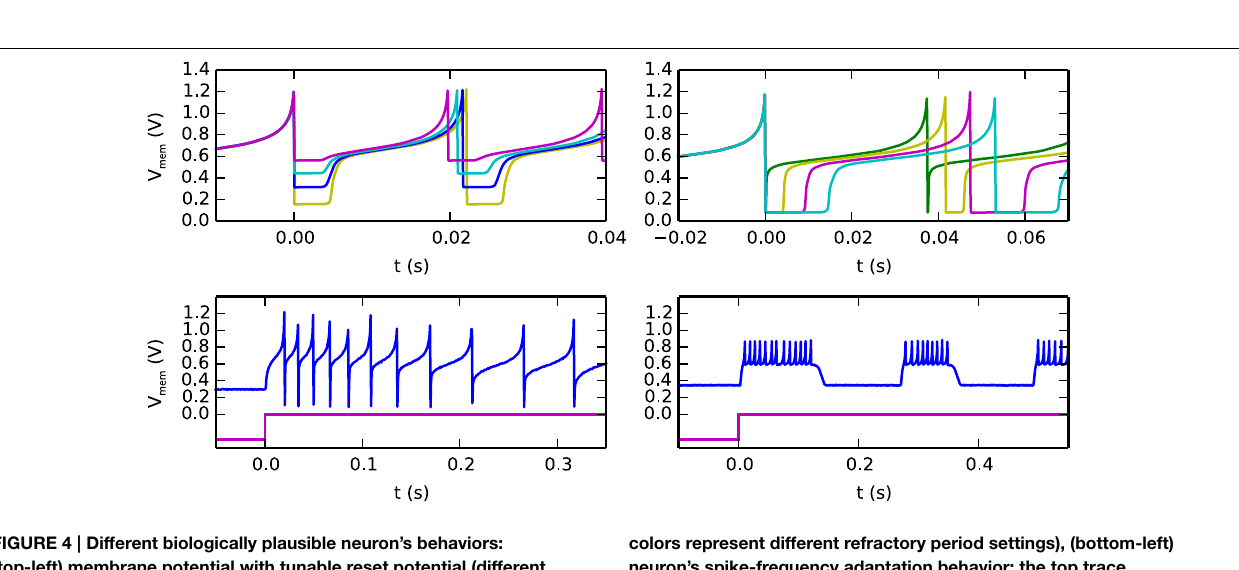
colors represent different refractory period settings), (bottom-left) neuron’s spike-frequency adaptation behavior: the top trace represents the membrane potential and the bottom one represents the input current, (bottom-right) neuron’s bursting behavior.